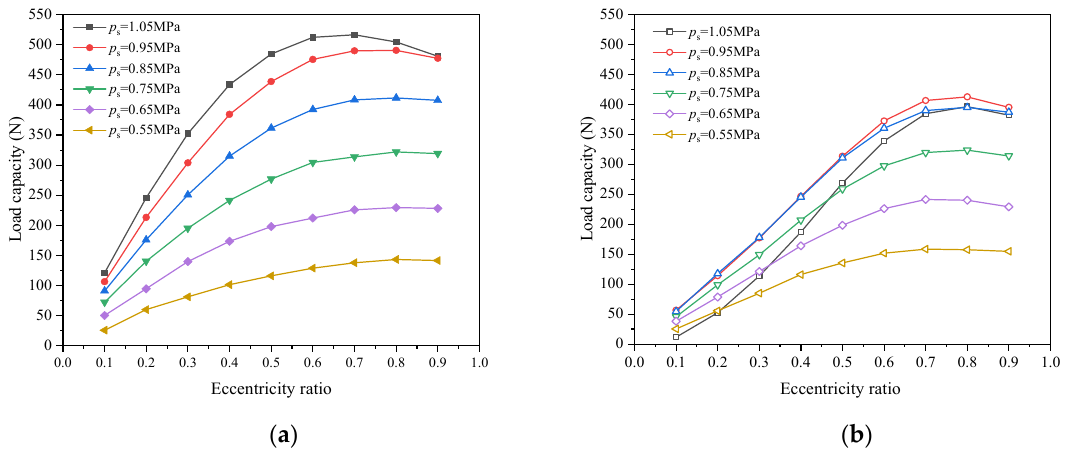
Figure 10. Load capacity variation with eccentricity ratio under different supply pressures ( d = 0.3 mm, h 0 = 25 μ m) ( a ) air ( b ) R134a.